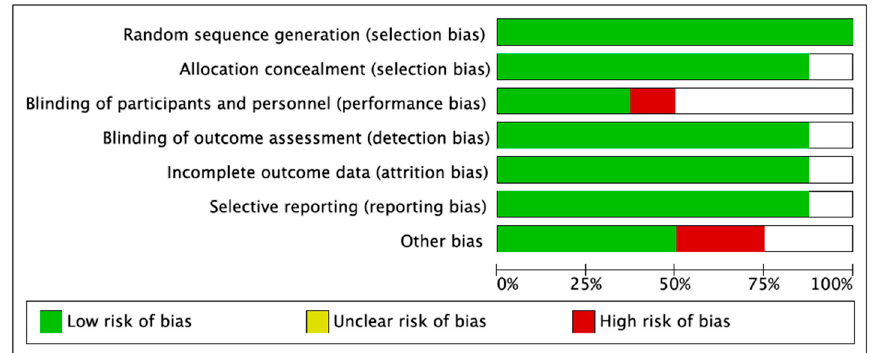
Figure 1. Risk of bias assessment.